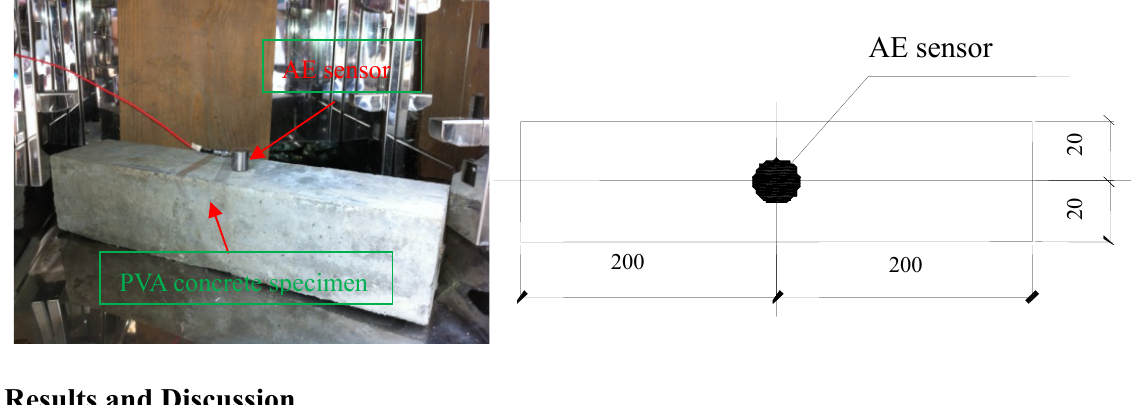
Figure 3. AE sensors arrangement (units: